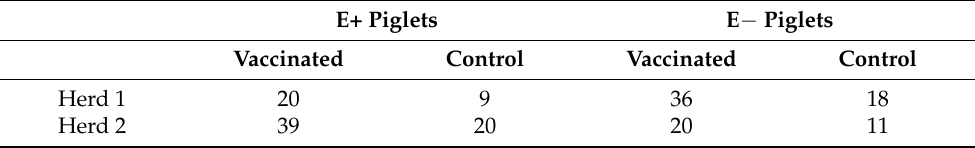
Figure 1. Schematic overview of the study design. Figure was made using Biorender.com. Table 1. Overview of the number of vaccinated and control piglets born from PRRSv-vaccinated ELISA-seropositive sows (E+ piglets) and PRRSv-vaccinated ELISA-seronegative sows (E − piglets) in two Belgian farrow-to-finish herds.